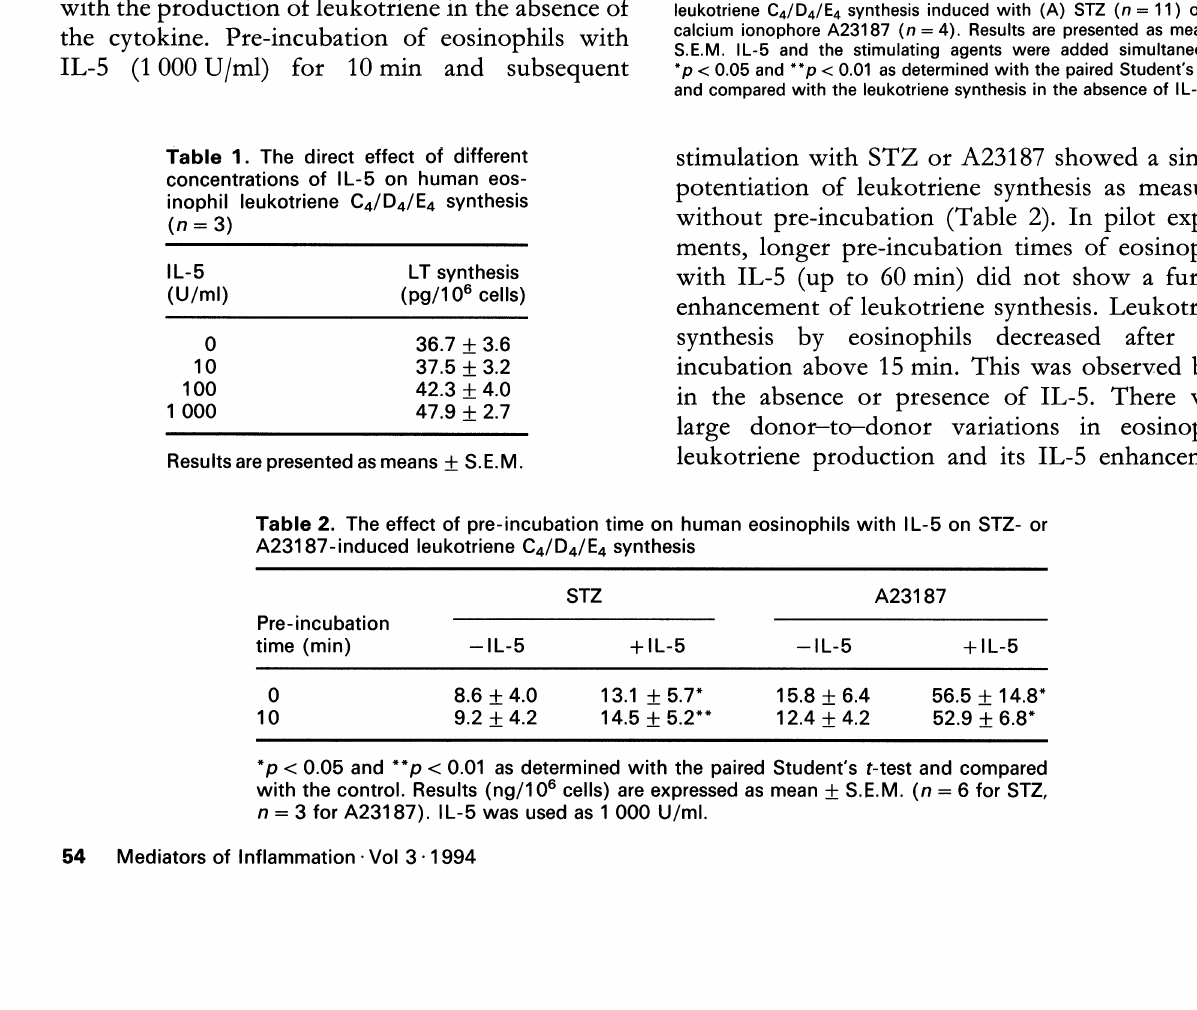
Table 1. The direct effect of different concentrations of L-5 on human eos- inophil leukotriene C4/D4/E4 synthesis (n=3)